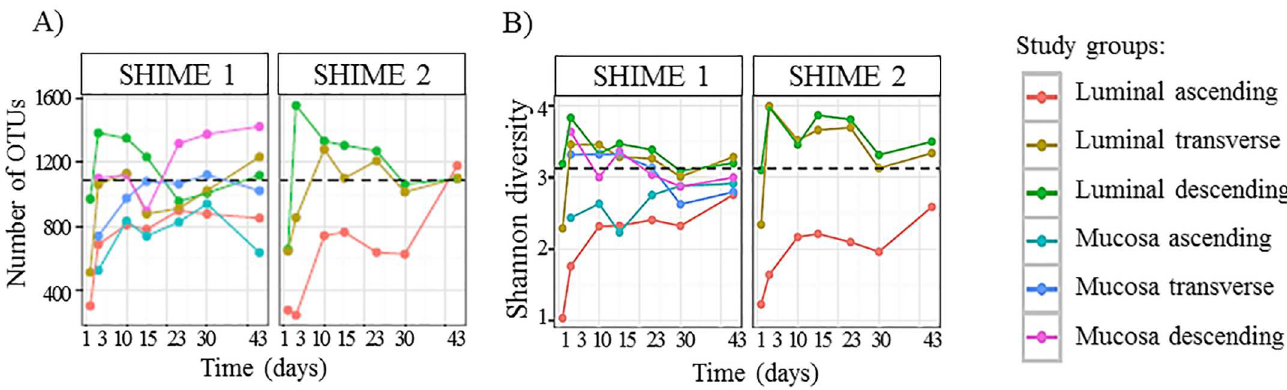
Fig 6. Alpha diversity measurements over time for the mucosal and luminal phase of the AC, TC, and DC regions. The black dotted line represents the Shannon diversity of the fecal sample used to inoculate the system. (A) The number of OTUs identified (B) Shannon diversity index.